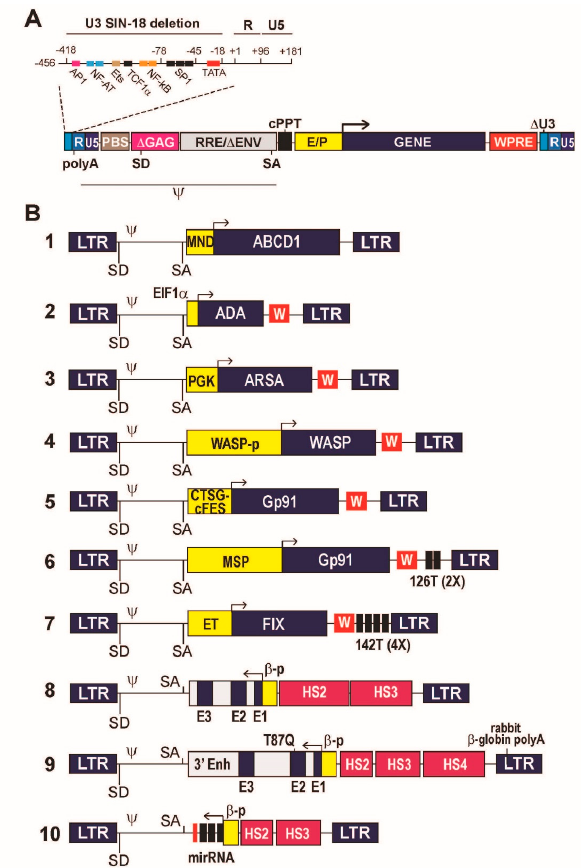
Figure 1. Schematic representation of HIV-1-derived lentiviral vectors (LVs) used in clinical appli- cations of gene therapy for monogenic diseases. ( A ) A prototype, third-generation LV provirus, featuring a disabling (SIN) deletion of the enhancer/promoter sequences in the U3 region of the long terminal repeat (LTR) up to position -18 from the viral transcription start site. The enlarged portion of the LTR shows the original arrangement of the transcription factor binding sites and TATA box in the HIV-1 U3 region, deleted in the LV LTR. The poly(A) signal-containing R and the U5 regions of the LTR are retained. PBS, primer binding site; ∆ GAG, deleted, non-coding portion of the GAG gene containing the D1 major HIV-1 splice donor (SD) site (CTG/GTGAGTAC); RRE, Rev-responsive element; ∆ ENV, deleted portion of the ENV gene containing the A7 HIV-1 splice acceptor (SA) site (TCGTTTCAG/A); cPPT, central polypurine tract; E/P, enhancer/promoter component of the expression cassette (the arrow represents the transcription start site); WPRE, woodchuck hepatitis virus post-transcriptional regulatory element; Ψ , extended packaging signal. ( B ) 1 to 10, schematic composition of the LVs described in the text. MND, modified enhancer/promoter of the murine myeloproliferative sarcoma virus; ABCD1, ATP-binding cassette, subfamily D, member 1 cDNA; EF1 α , short promoter of the elongation factor 1 α gene; ADA, Adenosine deaminase cDNA; W, WPRE; PGK, phosphoglycero kinase gene promoter; ARSA, arylsulfatase cDNA; WASPp, 1.6-kb extended Wiskott-Aldrich protein gene promoter; WASP, Wiskott-Aldrich protein cDNA; CTSG-cFES, hybrid promoter containing cFES regulatory regions and CTSG promoter. GP91, Gp91 phox cDNA; MSP, myeloid-specific promoter; 126T (2 × ) tandem repeat of the miR-126 binding site; ET, liver-specific transthyretin promoter/enhancer; FIX, coagulation factor IX cDNA; 142T (4 × ) tetrameric repeat of the miR-142 binding site; E3, E2, E1, exons 3, 2 and 1 of the human β -globin gene; β p, human β -globin gene promoter; HS2, HS3, HS4, hypersensitive site 2, 3 and 4 regions of the β -globin locus-control region; 3 (cid:48) Enh, 3 (cid:48) enhancer of the human β -globin gene. T87Q, codon substitution causing a tryptophan to glutamine amino acid substitution at position 87 of the β -globin protein; miRNA, gene encoding a shRNA/miR hybrid small nuclear RNA targeting the BCL11A transcription factor